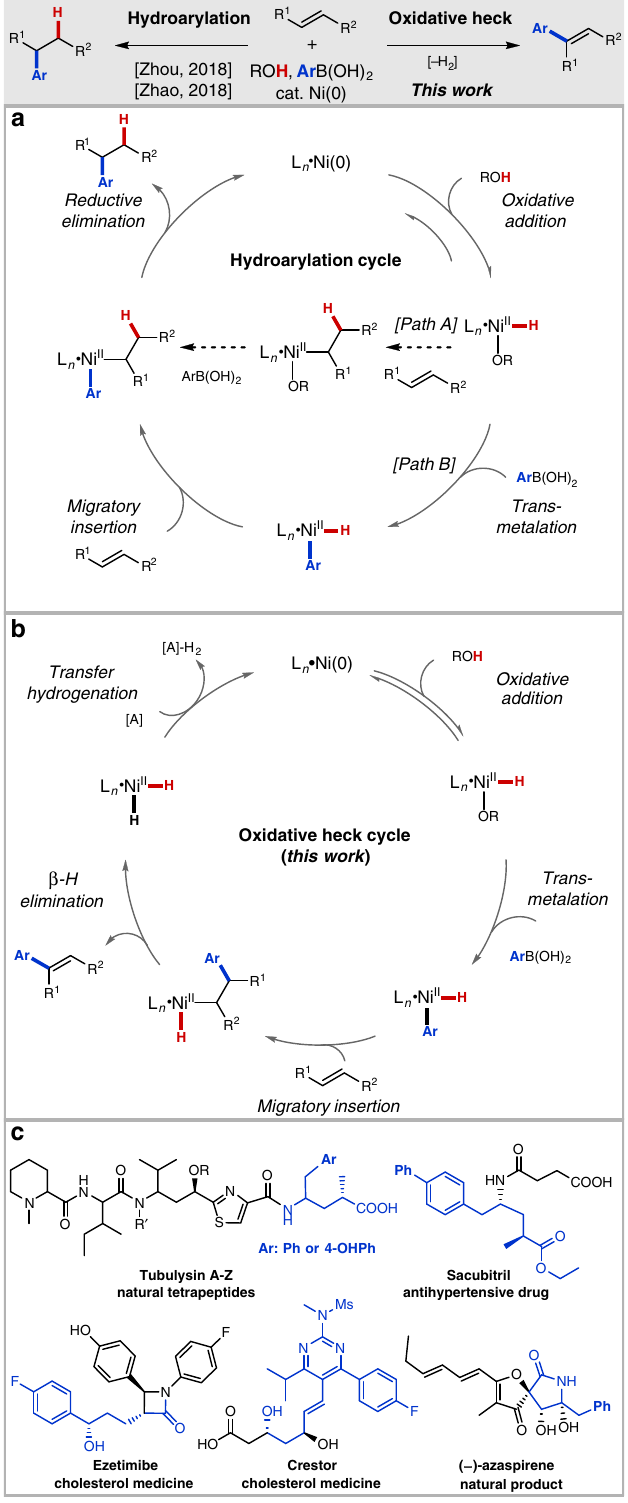
Fig. 1 Inspiration and motivation for the present study. a Catalytic cycle for previously reported Ni-catalyzed hydroarylation reaction. b Envisioned oxidative Heck reaction. c Relevant biologically active compounds containing γ -aryl carboxylic acid